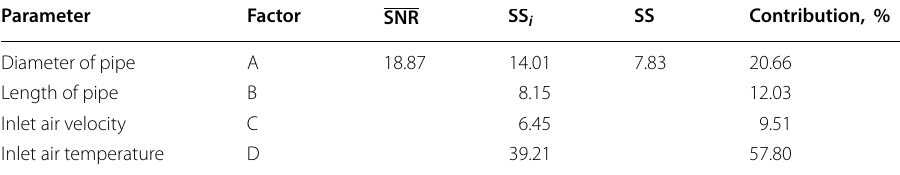
Table 7 Contribution of each parameter for maximum air temperature drop in EATHE Parameter